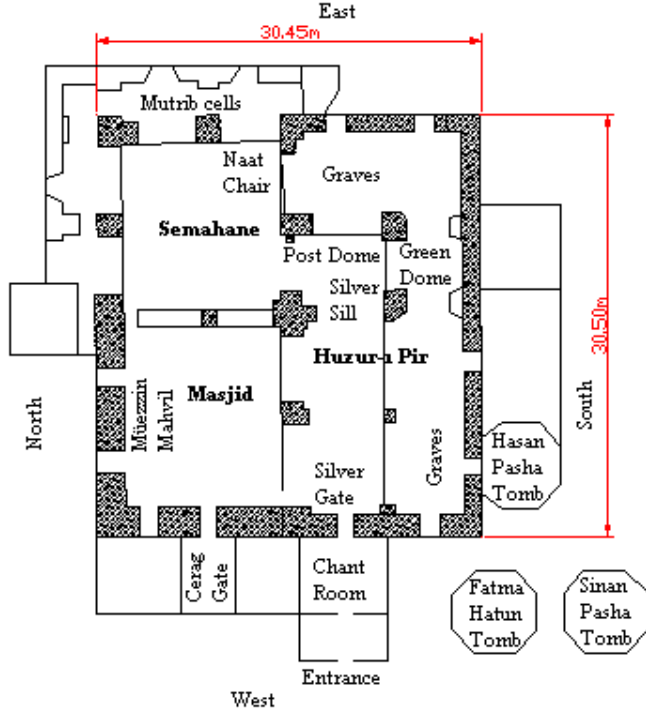
Figure 2. Ground plan of Mevlana Museum.